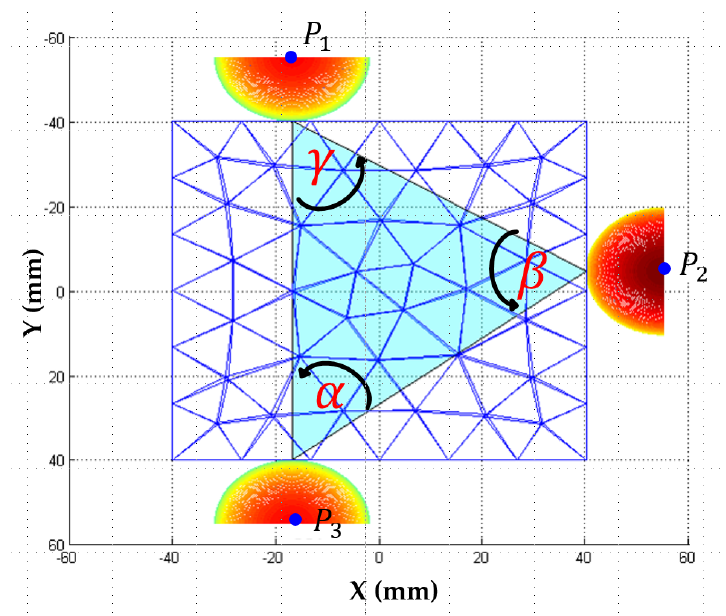
Figure 2. Force arrangement criteria.